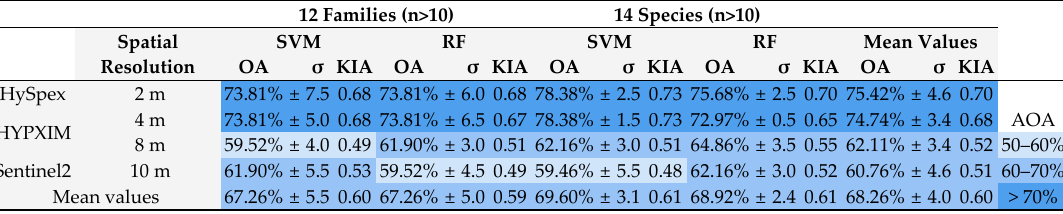
Table 6. Urban tree diversity classification results obtained using the 2-folds learning method and applied on reduced MNF image datasets, with SVM and RF classifiers according to subsets exhibiting at least 10 individuals per class.